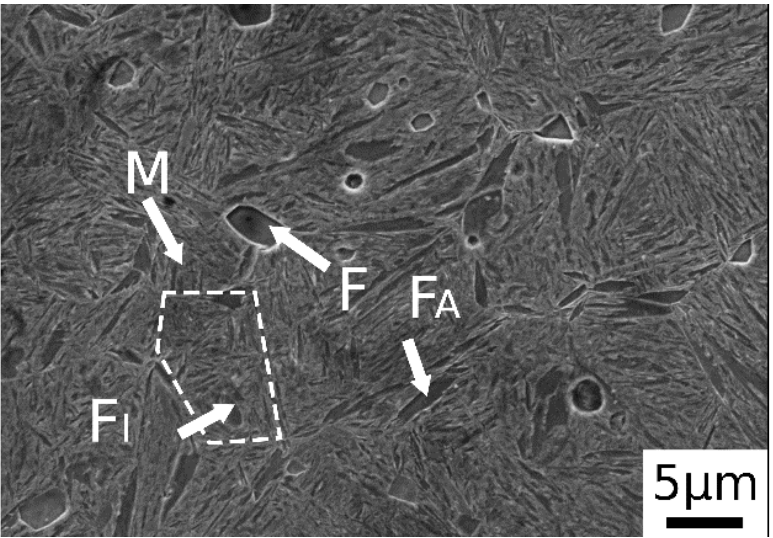
Figure 2. SE-SEM image of material after normalization (M martensite, F ferrite, F A allotriomorphic ferrite and F I idiomorphic ferrite).